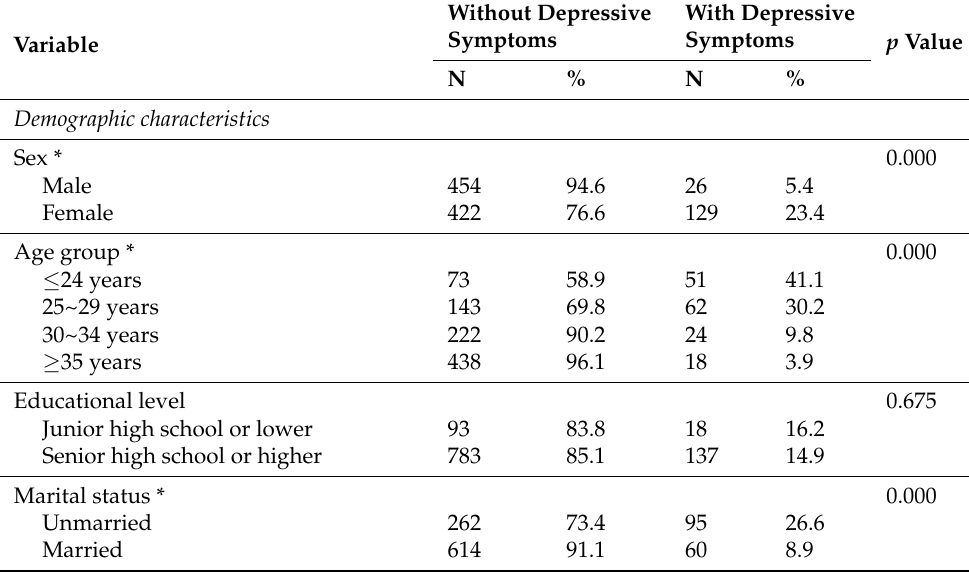
Table 2. Chi-squared analysis of factors associated with depressive symptoms among Indonesian migrant workers in